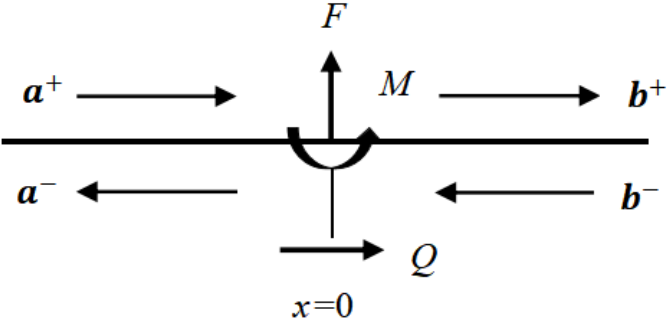
Figure 2. Waves generated by external force. (Reprinted from Ref. [37].).